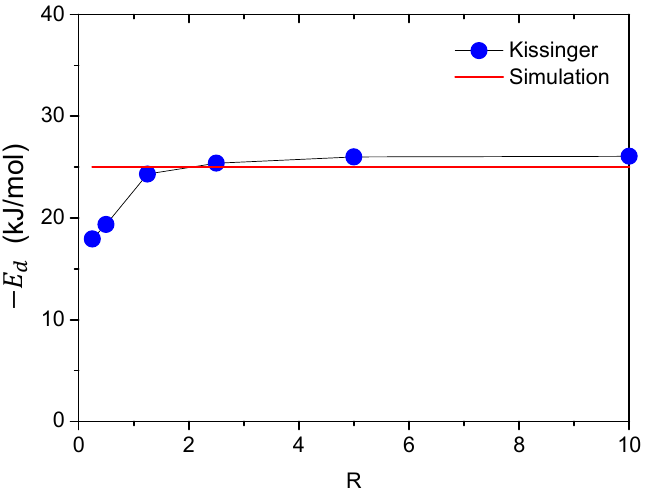
Figure 7. Comparison with the estimated trap deactivation energies E d using Kissinger theory ( blue dots ) and those prescribed in the simulation ( red line ) for different R values. Four different heating rates of 𝜙 = 200, 300, 400, and 600 K/h were used to generate the Choo–Lee plots.